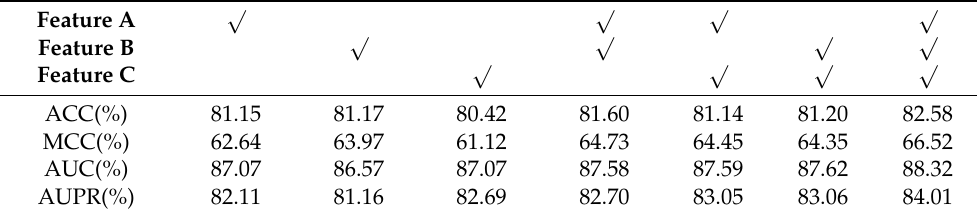
Table 2. Performance of single feature or multiple feature